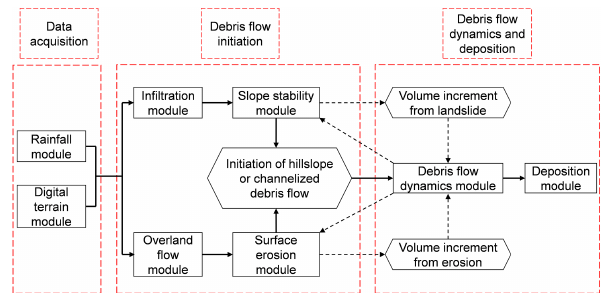
Figure 3. Framework of the integrated simulation of debris